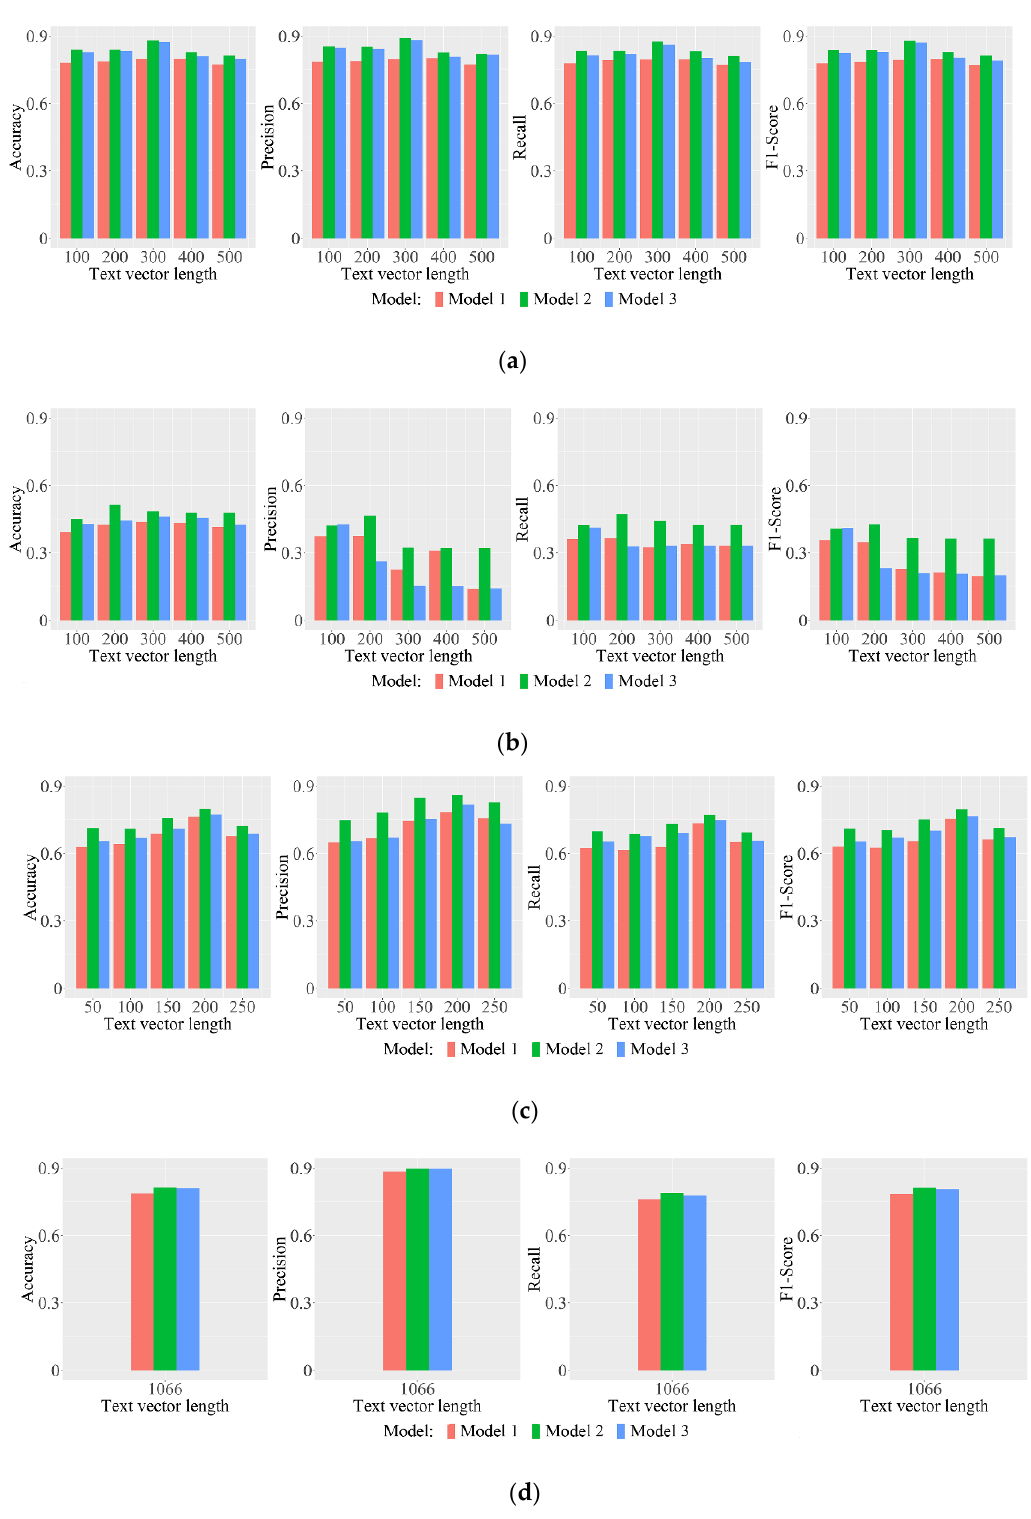
Figure 6. Effect of troubleshooting mode selection method based on SIF-SVM (comparison of Model 1, Model 2, and Model 3). ( a ) Effect of troubleshooting mode selection method based on SIF-SVM (fault phenomenon text feature extraction based on Word2Vec). ( b ) Effect of troubleshooting mode selection method based on SIF-SVM (fault phenomenon text feature extraction based on Doc2Vec). ( c ) Effect of troubleshooting mode selection method based on SIF-SVM (fault phenomenon text feature extraction based on LDA). ( d ) Effect of troubleshooting mode selection method based on SIF-SVM (fault phenomenon text feature extraction based on TF-IDF).